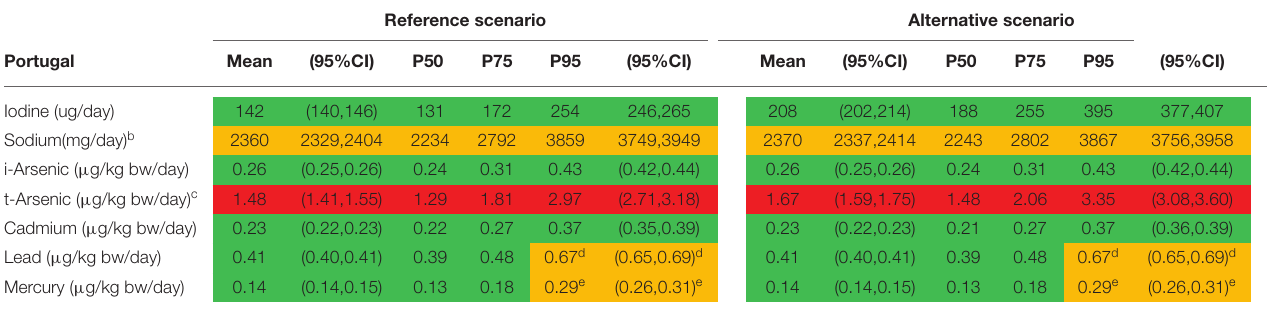
TABLE 6 | The intake of selected nutrients (iodine and sodium) and exposure to contaminants (arsenic, cadmium, lead, and mercury) in adults in in Portugal for the reference scenario and the alternative scenario a . Reference scenario Alternative